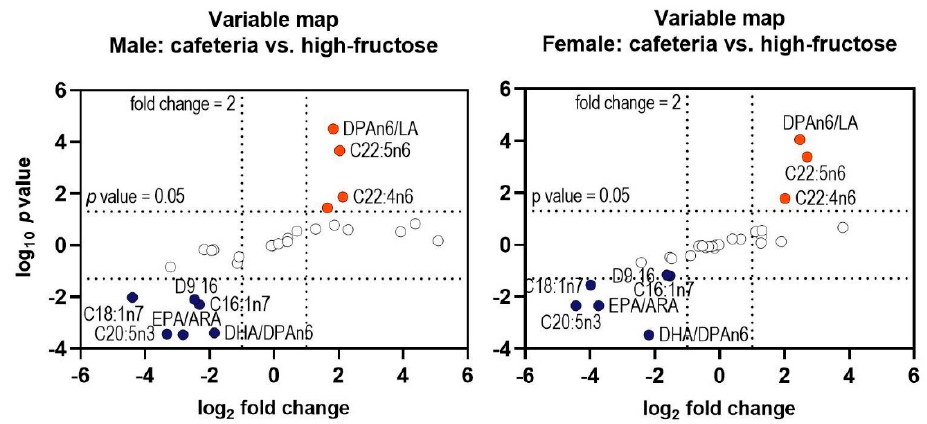
Figure 5. Variable map showing the variables with the highest significance between the Cafeteria diet and High-fructose diet in the male and female rats. Down-regulation << Average ratio >> Up-regulation. LA, linoleic acid.